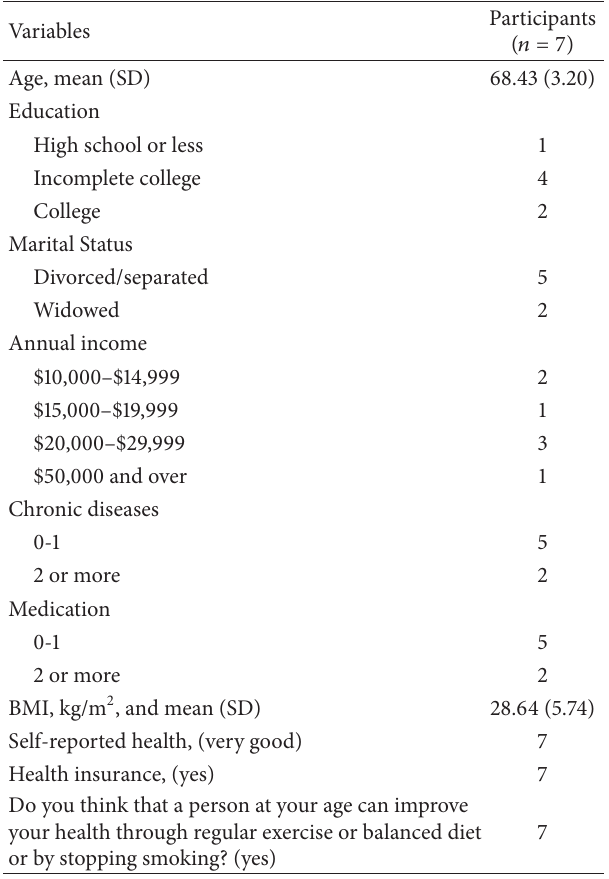
Table 1: Sociodemographic and health information of older African American women ( 𝑛 = 7 ) living in Urbana-Campaign,